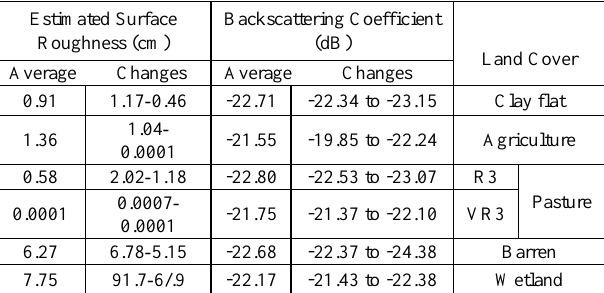
Table 3. Backscattering coefficient and estimated surface roughness in VH